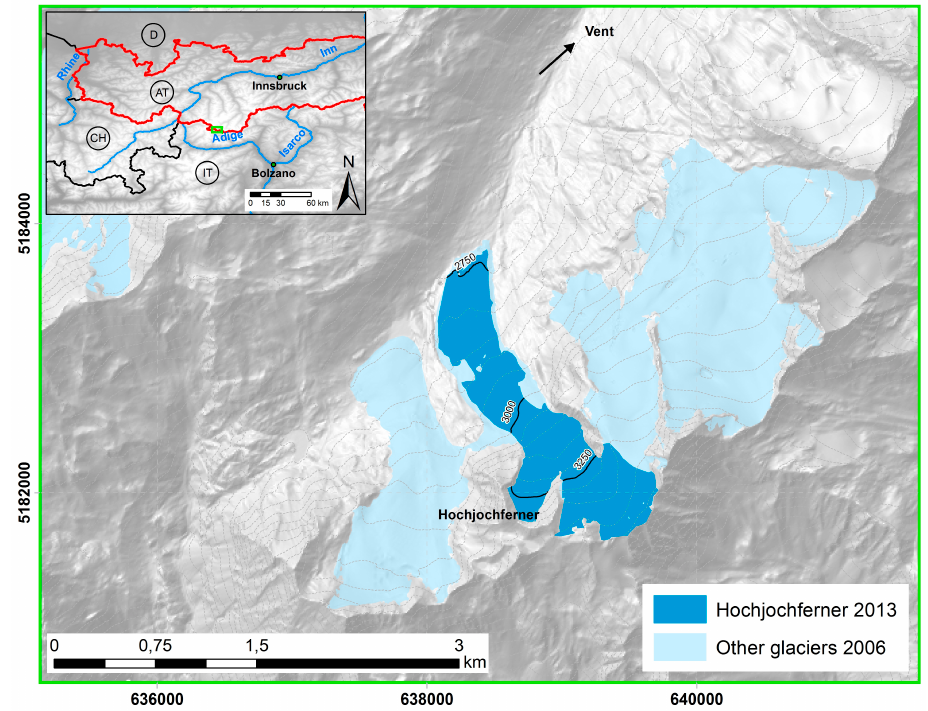
Figure 1. The study area in the Austrian Alps. One is the main part of Hochjochferner, which is investigated in this study. UTM 32 N.